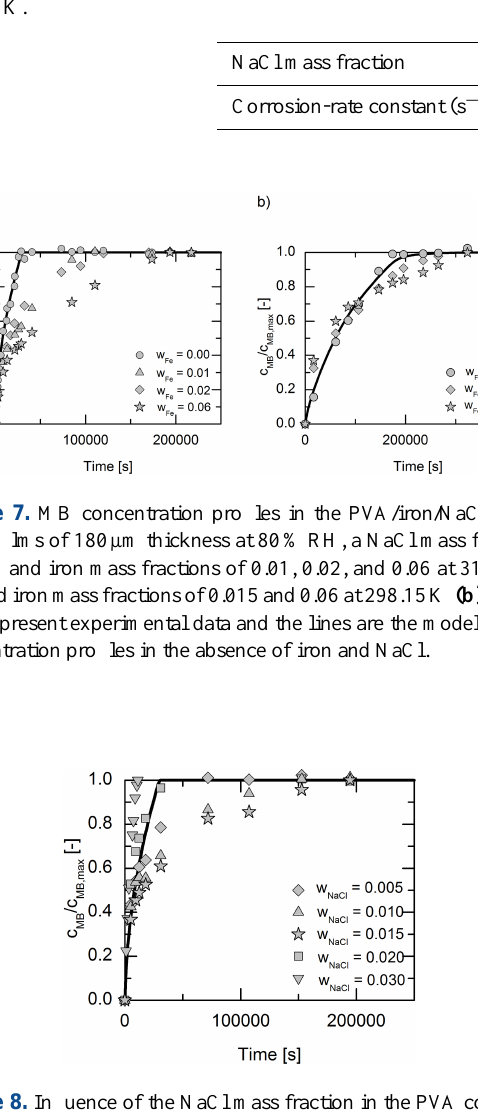
Figure 8. Influence of the NaCl mass fraction in the PVA compos- ite films with an iron mass fraction of 0.05 and 180µm thickness at 313.15K and RH of 80%. The symbols represent experimental data; the line is the modeling of the MB concentration profile in the absence of iron and NaCl.